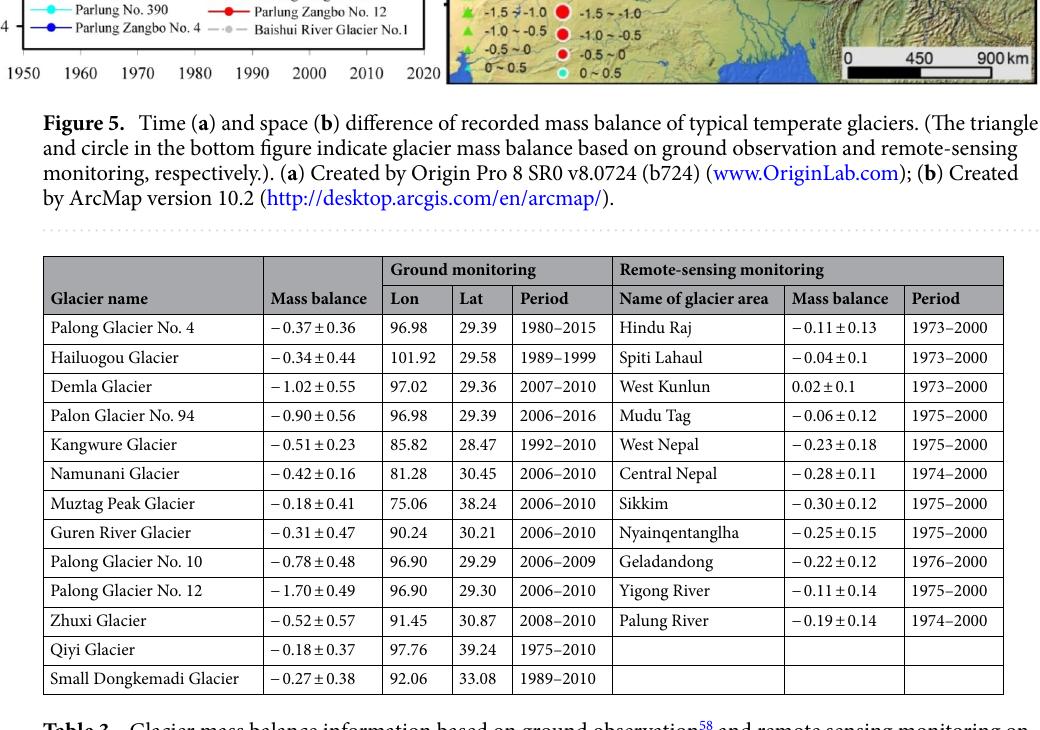
Table 3. Glacier mass balance information based on ground observation 58 and remote sensing monitoring on the QTP 55